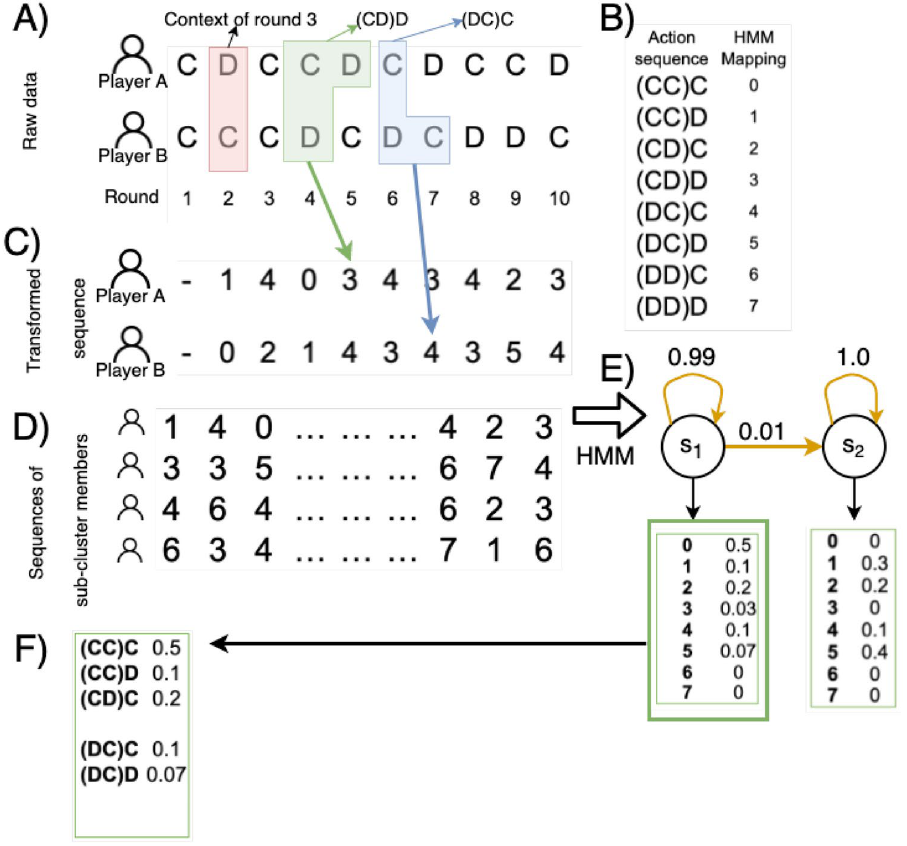
Figure 1. From treatment data to HMM. ( A ) At the top, the first 10 rounds between a player and her opponent, In the red box, the actions of round 2, which represent the context for round 3. ( B ) The action sequence mapping, with the green box in panel A representing the action sequence ( CD ) D for player A and the blue box ( DC ) C also in panel A for player B in rounds 5 and 7 respectively. ( C ) The transformed sequence for players A and B into integers so the HMM with the mapping table in panel B. ( D ) The resulting sequences are grouped given their sub-cluster and then processed by the HMM in panel ( E ). In this example, the resulting HMM is a model with two states s 1 and s 2 with transition probabilities given by the yellow arrows with emission probabilities in the boxes below. ( F ) HMM visualization. Note that all the emission probabilities ≤ 0.05 and all transition probabilities ≤ 0.01 were not taken into account for readability. The resulting HMM emission table is colored green from the hidden state s 1